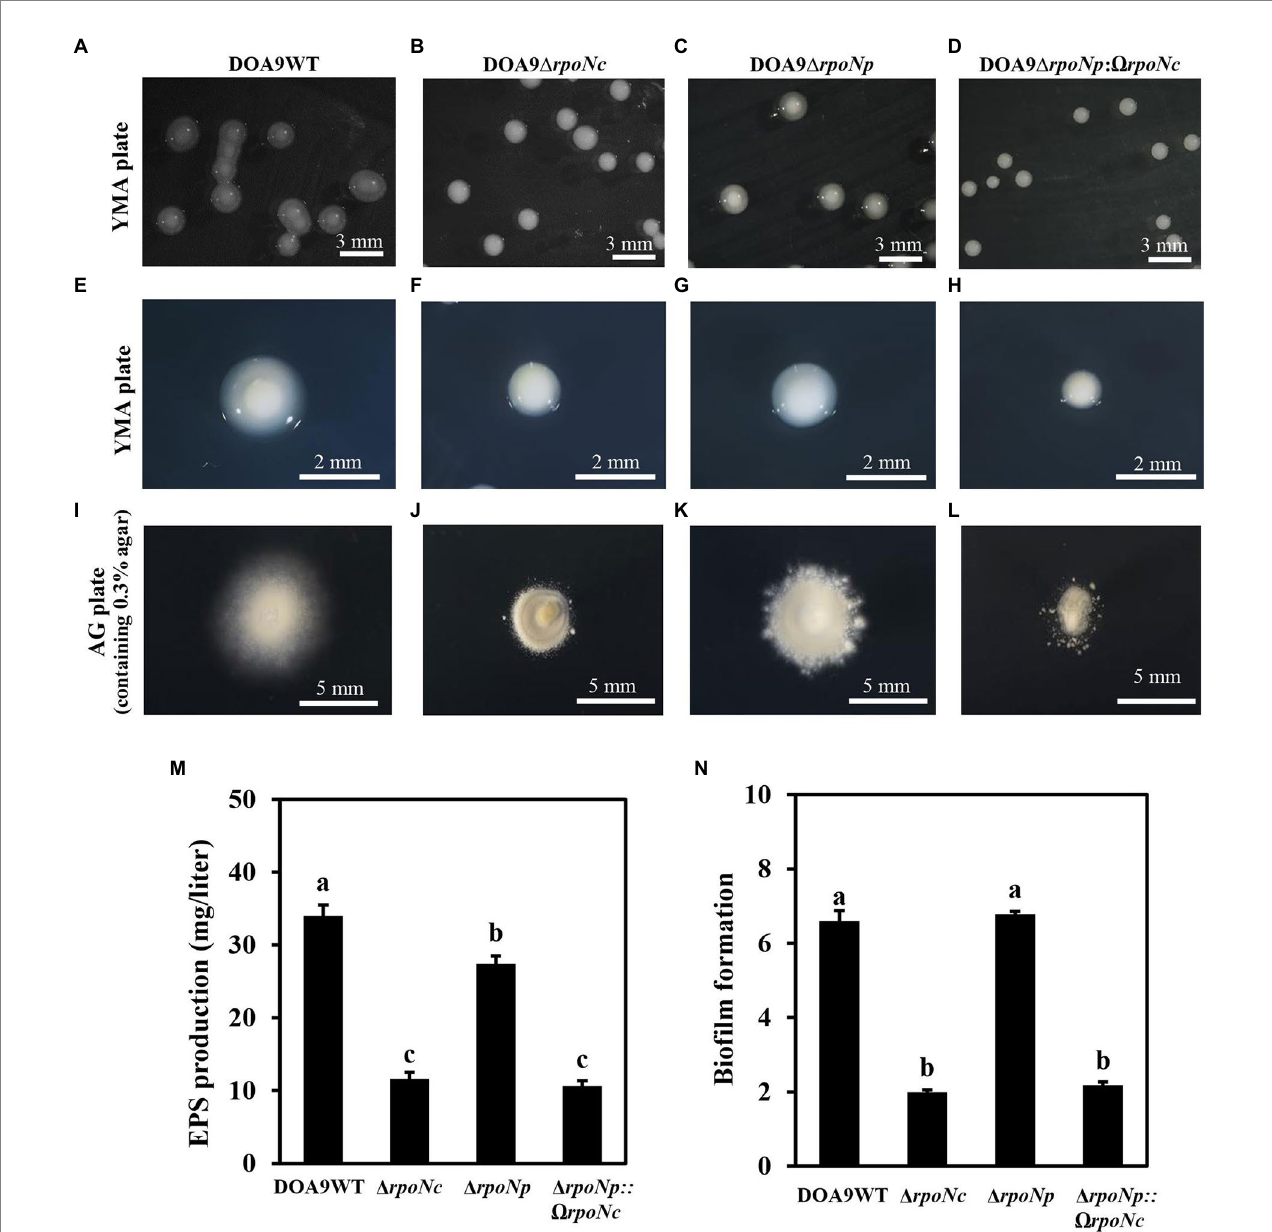
FIGURE 3 Colony morphology and growth phenotype of rpoN mutants of Bradyrhizobium sp. strain DOA9. Colony morphology of WT DOA9 (A) and rpoN mutant (B–D) strains after 7 days of cultivation on YEM agar plates at 28 ° C. The average size of single colony of WT DOA9 (E) and rpoN mutant (F–H) strains were observed and photographed under microscopy. Swimming motility of WT DOA9 and rpoN mutant strains on 0.3% BNM-B agar plates. After 7 days of incubation at 30 ° C the diameter of colony was measured (I–L) . Amount of EPS found in the bacterial culture supernatant of WT DOA9 and rpoN mutant cells after 7 days of incubation in YEM medium ( M ). Biofilm formation of WT DOA9 and rpoN mutant strains after 14 days of cultivation in BNM-B medium. The amount of biofilm formation was detected by coloring bacterial cells adhered to the plastic surface of Falcon tubes with 0.1% crystal violet and subsequently quantified by measuring the OD 570 of the ethanol eluted crystal violet (N) . Data sets represent mean values of five replicates, and statistically significant differences (ANOVA Tukey test; p < 0.01) are